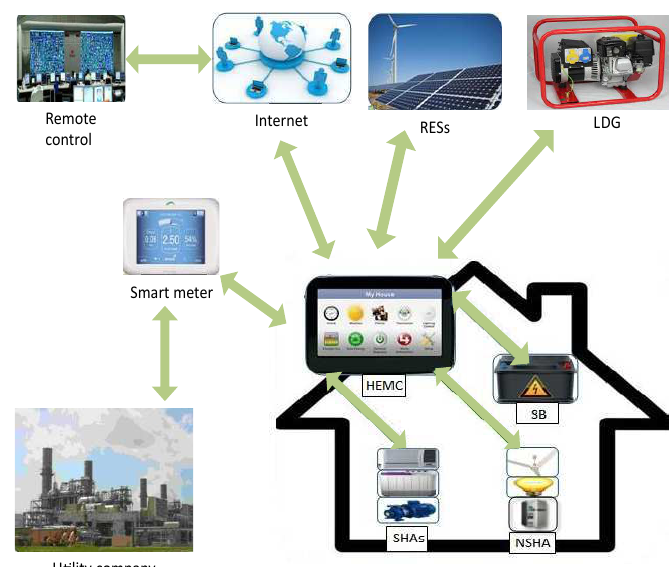
Figure 1. Architecture for demand response synergized with renewable energy sources and energy storage systems optimal dispatch integrated with load shedding-compensating dispatchable generator based home energy management system for a smart home